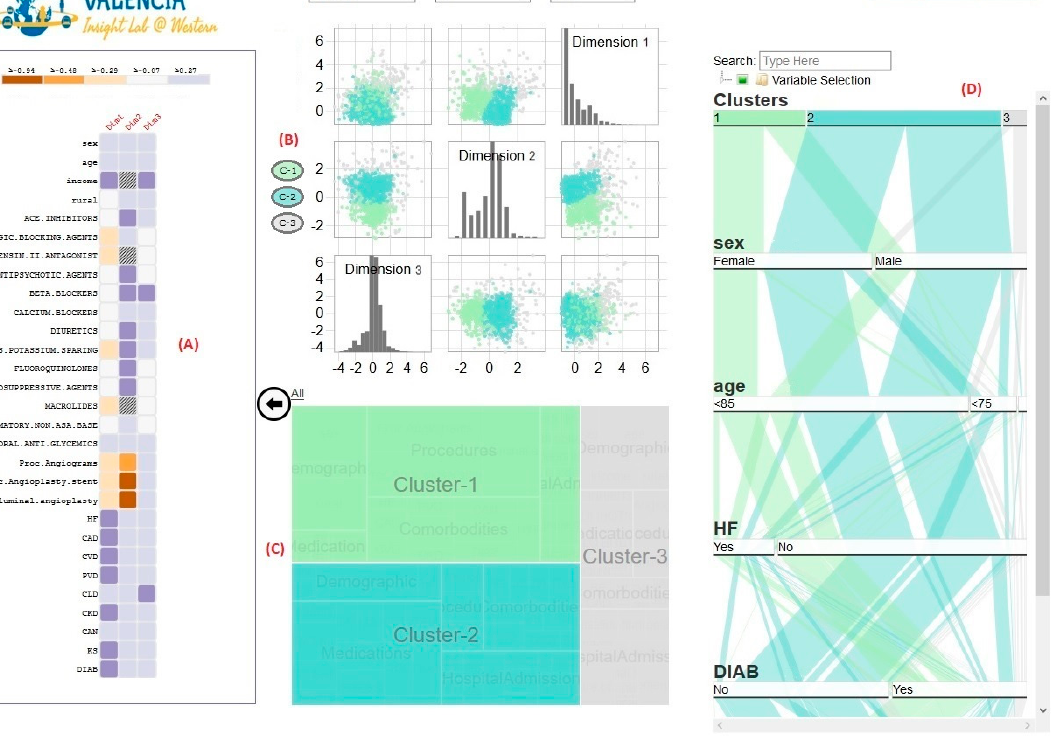
Figure 3. The dimensionality reduction (CA) view containing ( A ) association subview, ( B ) projected-observations subview ( C ) hierarchical subview, and ( D ) frequency subview.